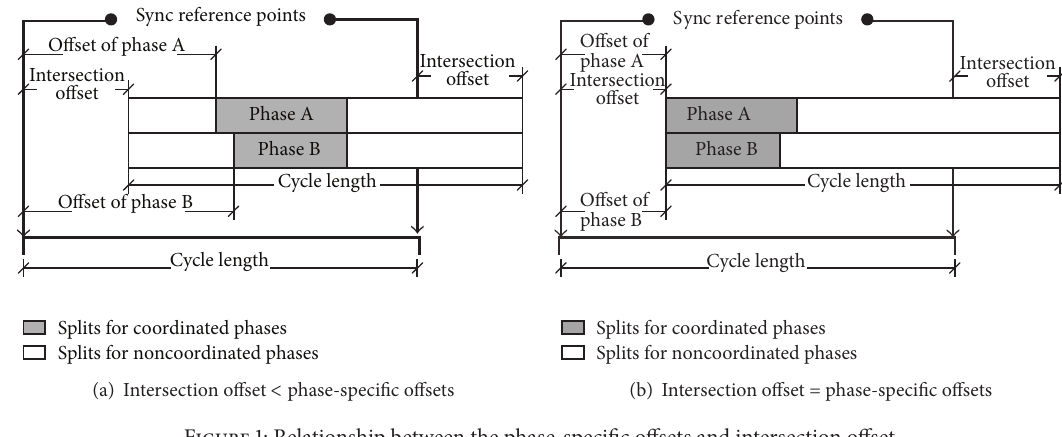
Figure 1: Relationship between the phase-specific offsets and intersection offset.